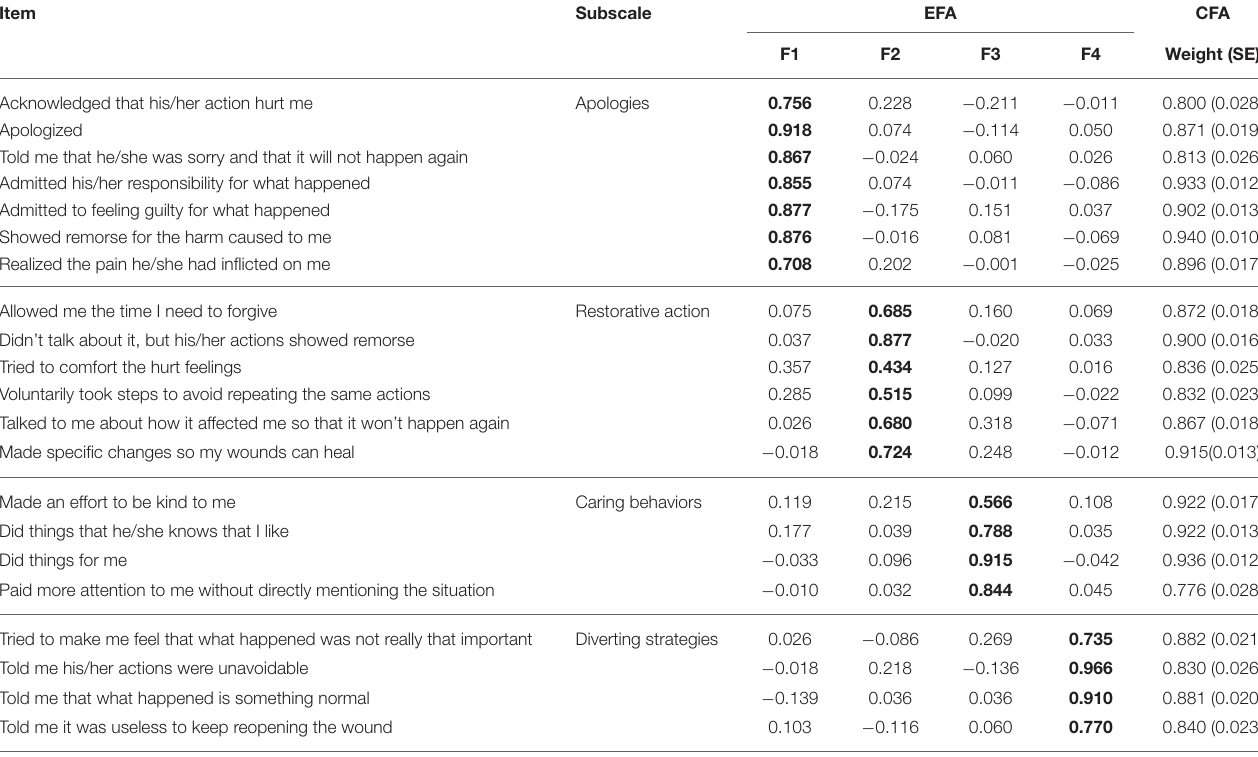
TABLE 1 | Factorial weights for the EFA and the CFA. Item